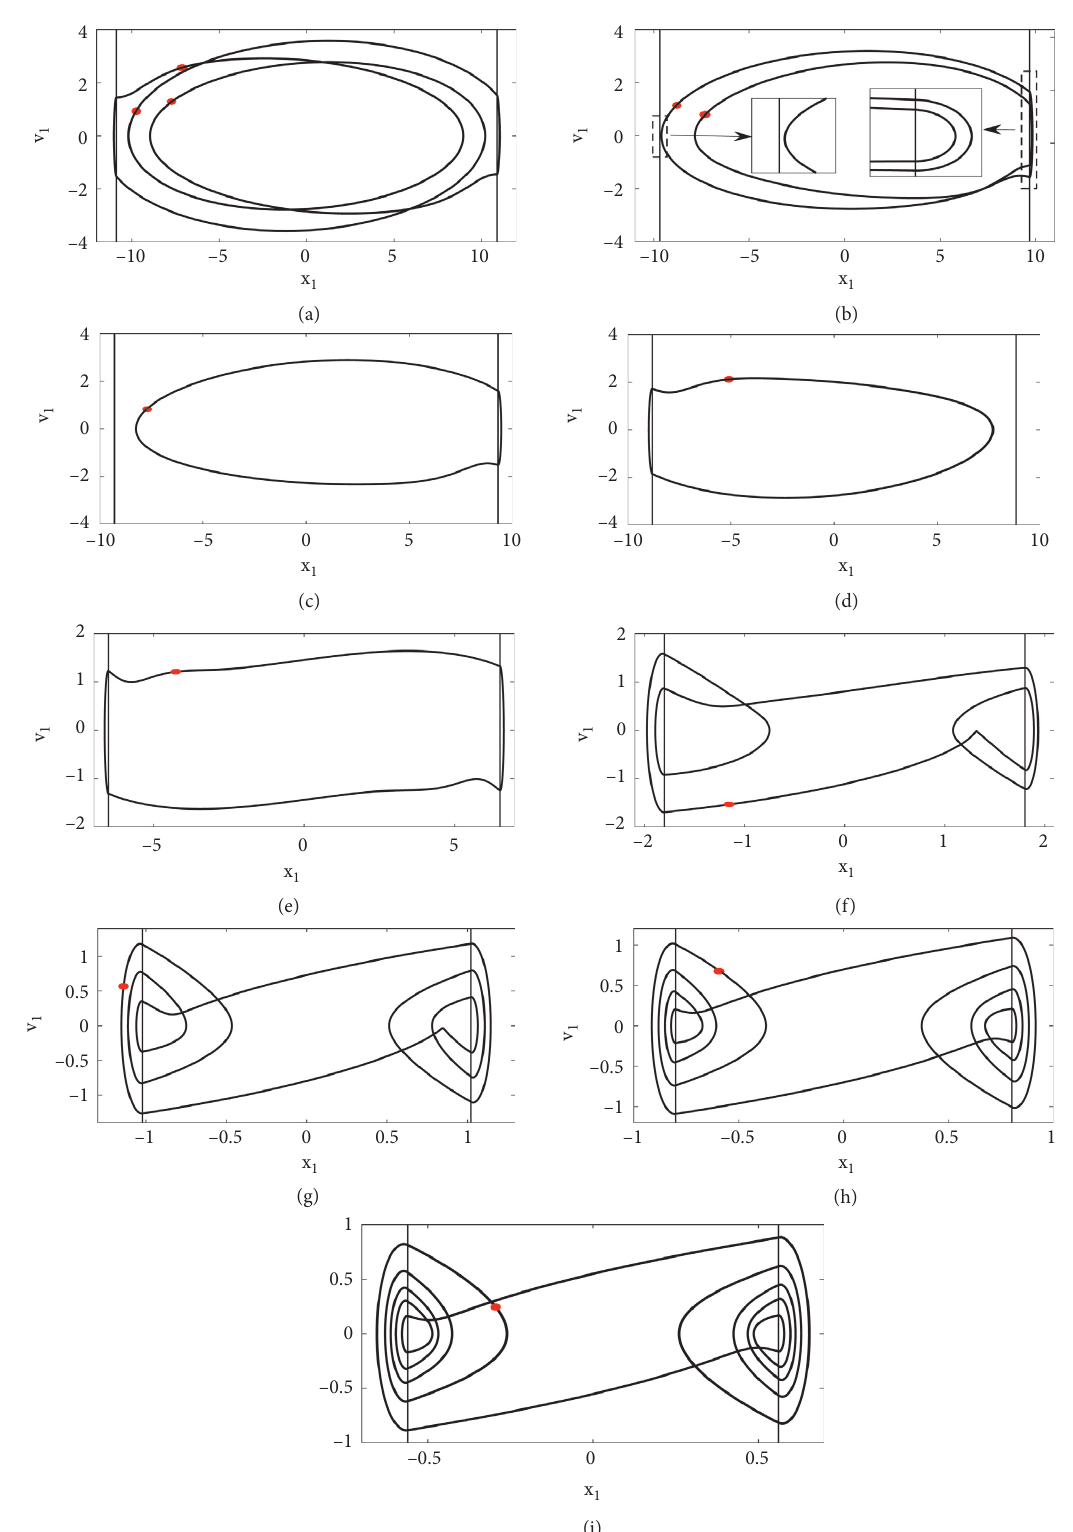
Figure 9: The phase diagrams for periodic motions in regions (a)–(i) of Figure 8. Poincare sections are marked by red dots on the phase